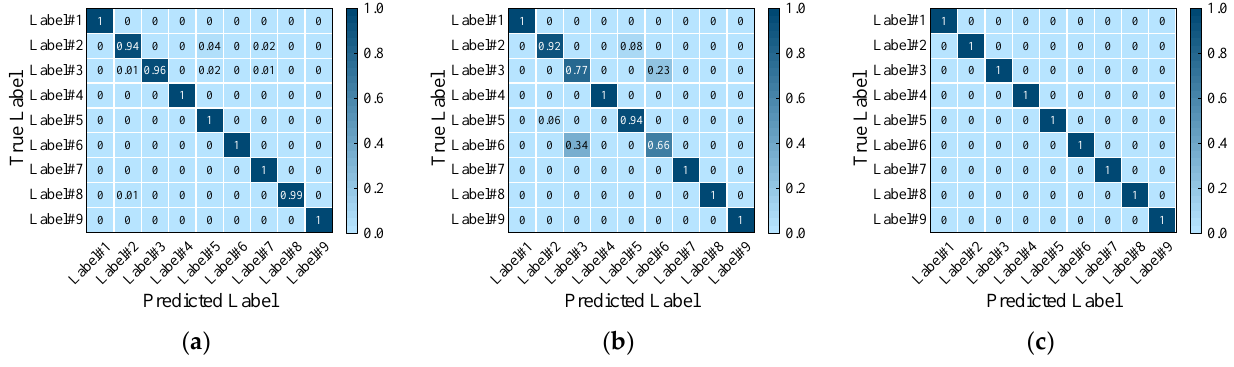
Figures 12 and 14, it can be seen that with the increase of the target domain samples in the training dataset, the accuracy, precision, recall, and F1 scores all increased.